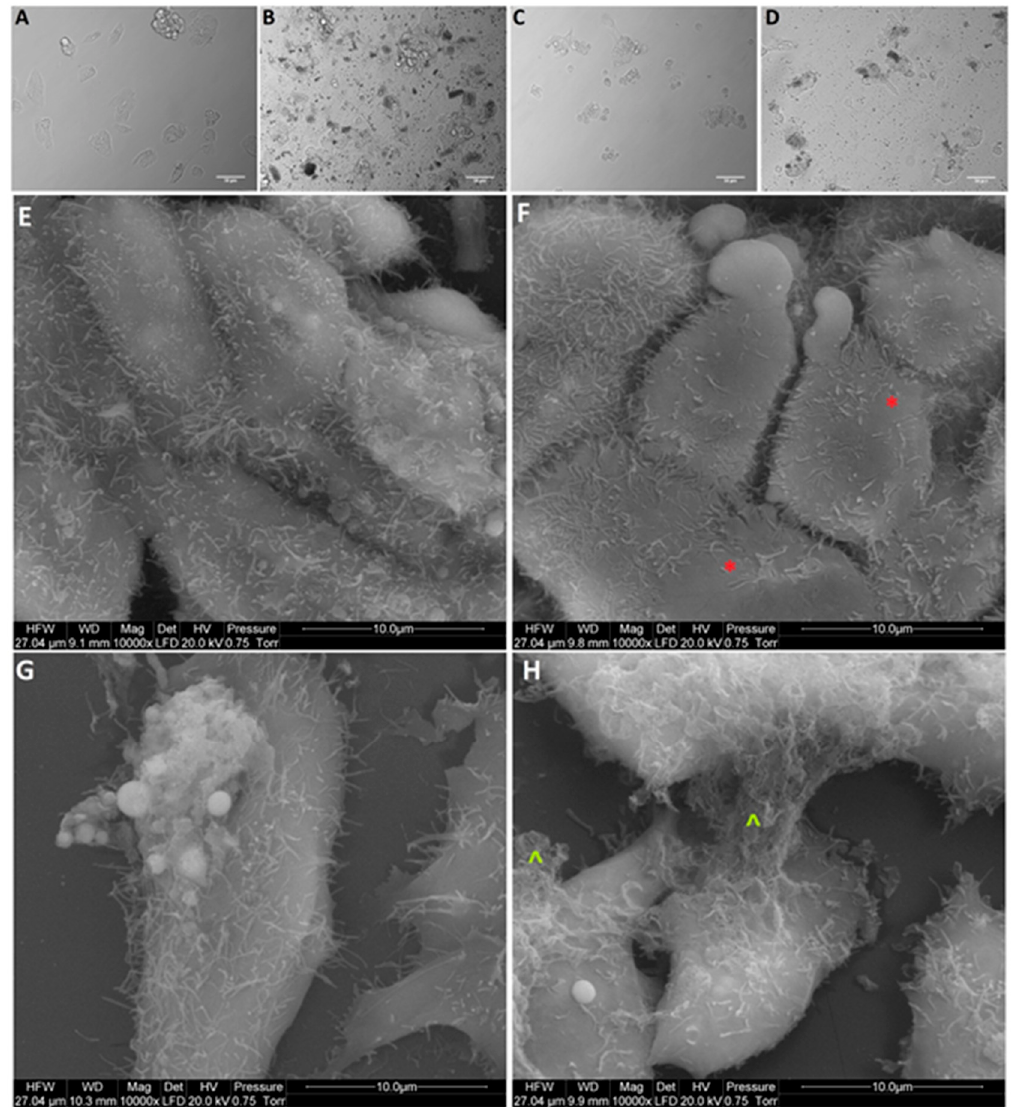
Figure 6. Morphology of HepG2 liver cancer cells. ( A , E ) untreated cells (control group), ( B , F ) cells treated with nanocomplexes of graphene oxide and platinum (GO-NP-Pt), ( C , G ) cells treated with platinum nanoparticles (NP-Pt), ( D , H ) cells treated with graphene oxide (GO). Red * —point on GO-NP-Pt at cell membrane. Green ˆ —point on GO at cell membrane. ( A–D ) Light optical microscopy. ( E–H ) Scanning electron microscopy. Notes: A–D scale bars 50 µ m, E–H scale bars 10 μ m. Abbreviations: GO-NP-Pt — nanocomplexes of graphene oxide and platinum nanoparticles, NP-Pt —